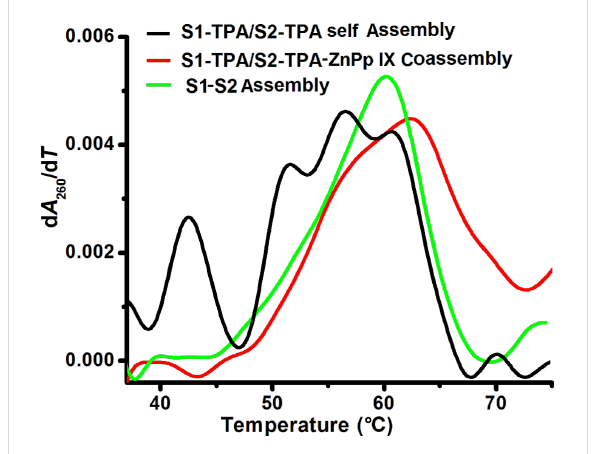
Figure 6: The first-order-derivative melting curves of nanofibers (S1 DNA–TPA/S2 DNA–TPA triconjugate Zn PpIX coassembly) from self- assembly of DNA–TPA triconjugates from absorbance of DNA in solu- tion at 260 nm.